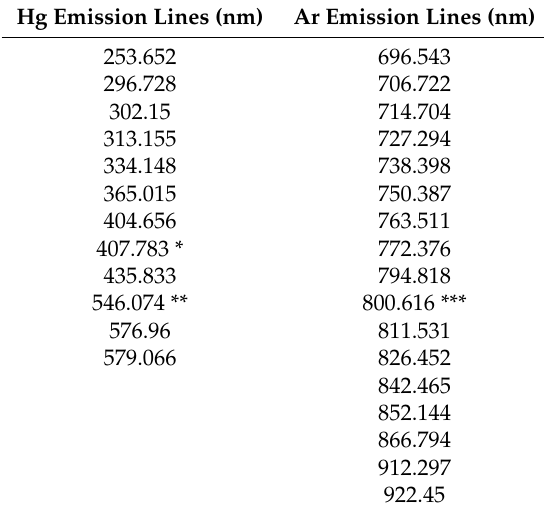
Table 2. Hg / Ar emission lines as reported from Ocean Optics for their Hg-1